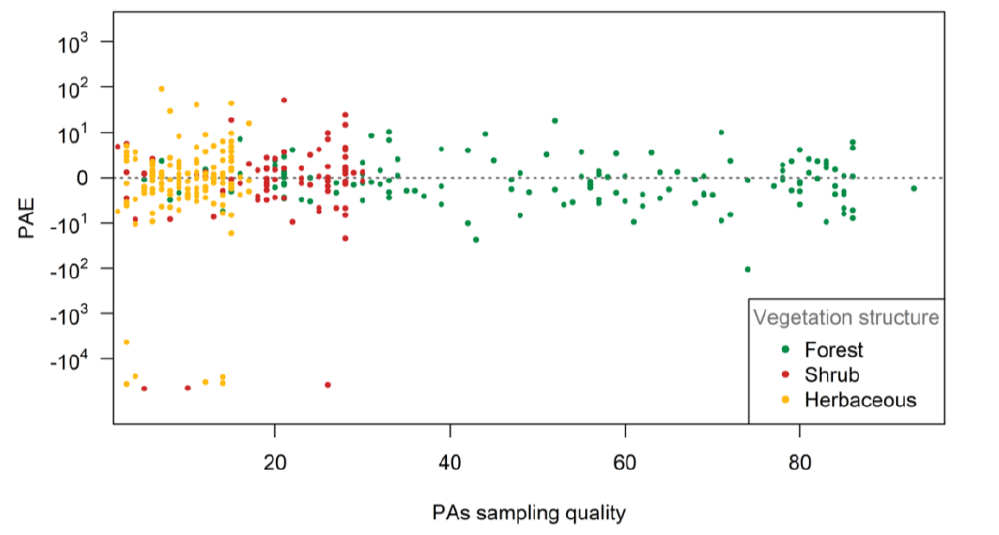
Figure 1: Estimated Protected Areas effect per species (PAE) (represented on a log scale in both negative and positive values), against PAs sampling quality, per vegetation structure type of the routes. PAs sampling quality is the number of routes within the species’ kernel with at least 50% of the buffer area covered by Protected Areas. Each point in the plot corresponds to a species, and each species can be represented by up to three points, one for each vegetation structure type.